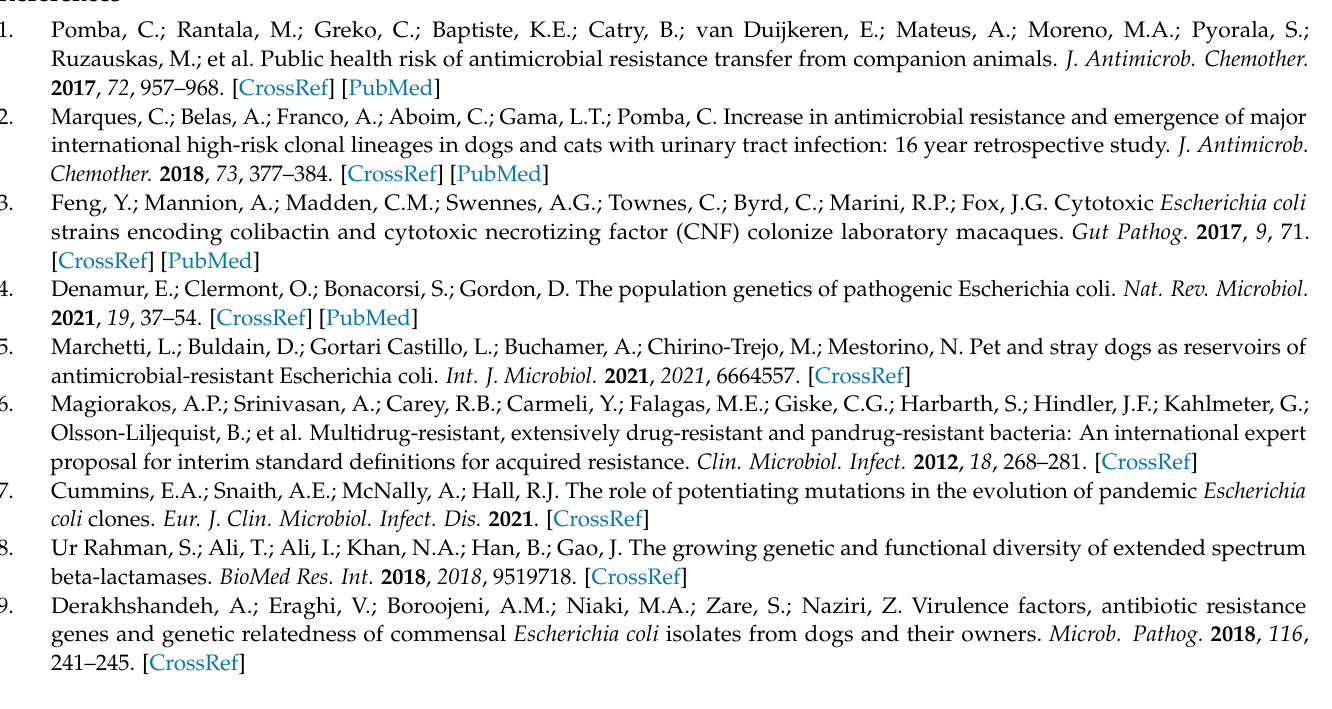
for E. coli ; Table S2: Percentages of antimicrobial resistance in E. coli of different origins and years; Table S3: Drug resistance pattern of E. coli . Table S4: Percentage of antimicrobial resistance in ESBL- E. coli of different origins and years; Table S5: Drug resistance pattern of ESBL- E. coli ; Table S6: Detection rates of drug resistance genes; Table S7: Phylogenetic grouping of E. coli in 2021; Table S8: Phylogenetic grouping of ESBL- E. coli ; Table S9: Collection Information of E. coli ; Table S10: PCR primers and conditions; Figure S1: Drug resistance pattern of E. coli . References [58–73] are mentioned in Supplementary Materials